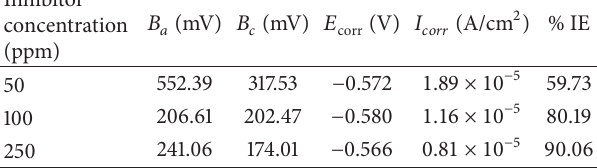
Table 1: Inhibition efficiency values for carbon steel in 1MHCl with different concentrations of AMPS calculated by polarization